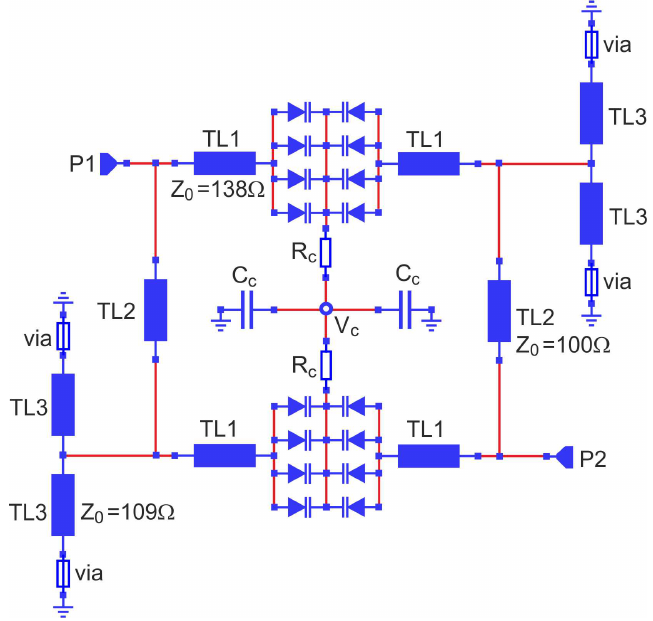
Figure 9. Schematic diagram of the proposed tunable bandpass filter.